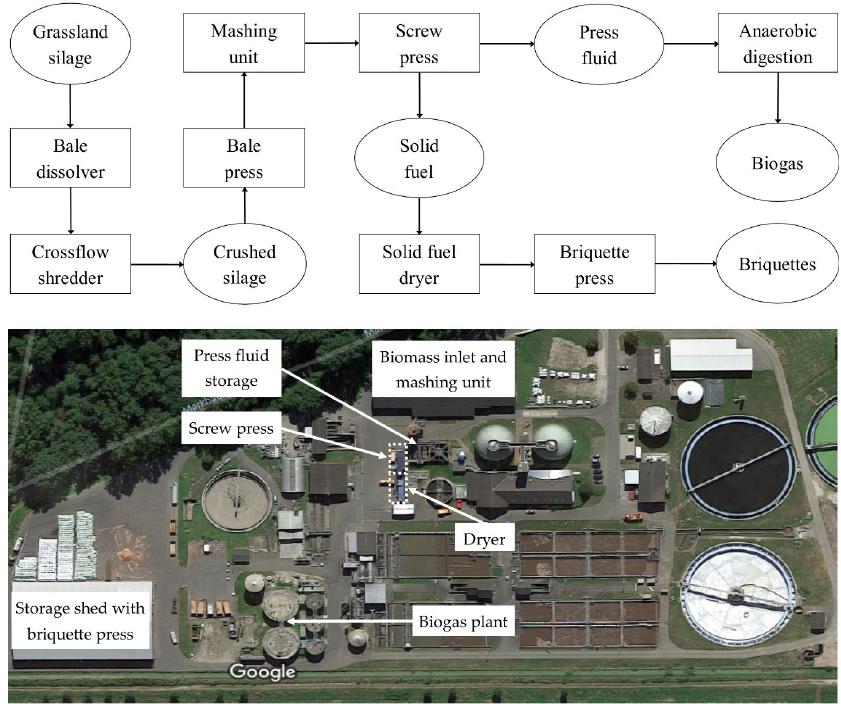
Figure 1. ( Top ) Layout of the commercial scale IFBB process at Baden-Baden, the processes involved are illustrated using rectangles and raw materials, intermediate and end products are illustrated in round forms; ( Bottom ) Overview of the Commercial scale IFBB unit at the sewage water treatment plant in Baden-Baden based on Google maps image.